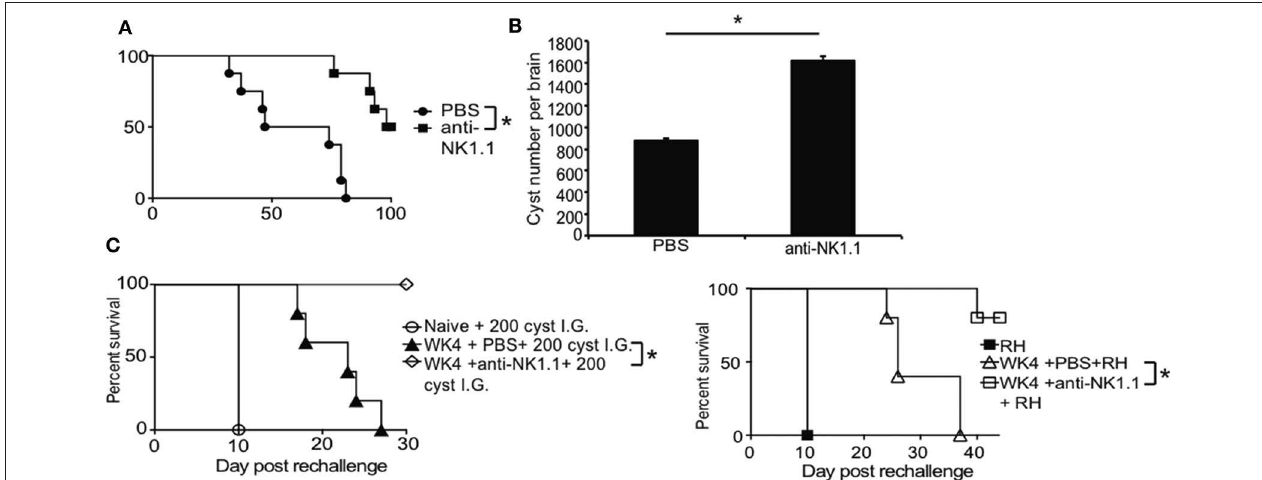
FIGURE 2 | NK cells promote immune exhaustion and parasite reactivation during chronic T. gondii infection. C57BL/6 mice were infected orally with 10 cysts of ME49 and infection outcome monitored. (A) Survival after 200 µ g anti-NK1.1 or 200 µ l 1 X PBS every 2nd day starting at week 5 p.i. Graph presents pooled data from 3 independent experiments, n = 4–5 mice per group (B) Brain cyst burden after anti-NK1.1 or 1 X PBS treatment starting at week 5 p.i. Graph presents data from 1 experiment repeated independently 2 times with n = 5 mice per group. (C) Survival of chronically infected animals after lethal secondary 200 ME49 cyst or 1,000 tachyzoite RH strain challenge with or without anti-NK1.1 treatment. Experiments were repeated independently 2 times with n = 4–5 mice per group. All graphs are mean ± SD. *denotes significance as p ≤